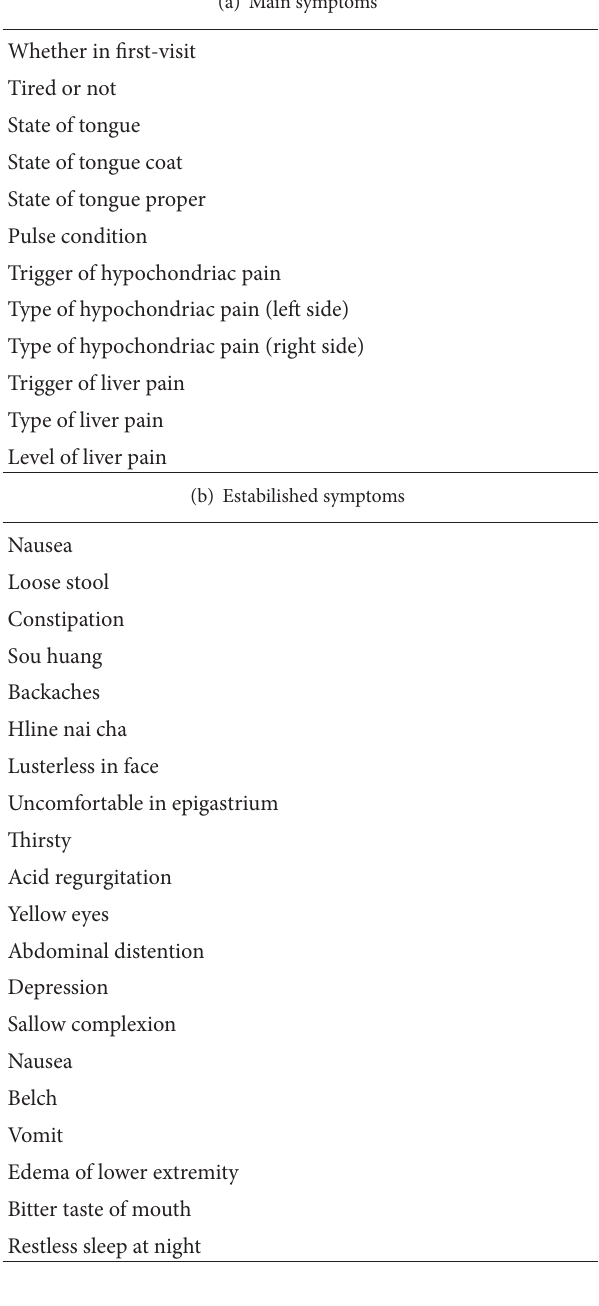
Table 2: Information for template design ( 3 ). Table 3: Information of template design for fatty liver ( 1